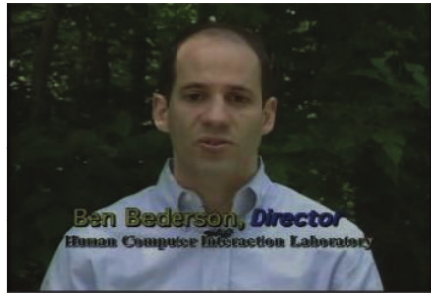
Figure 3: Key-frames extracted from video hcil 2002